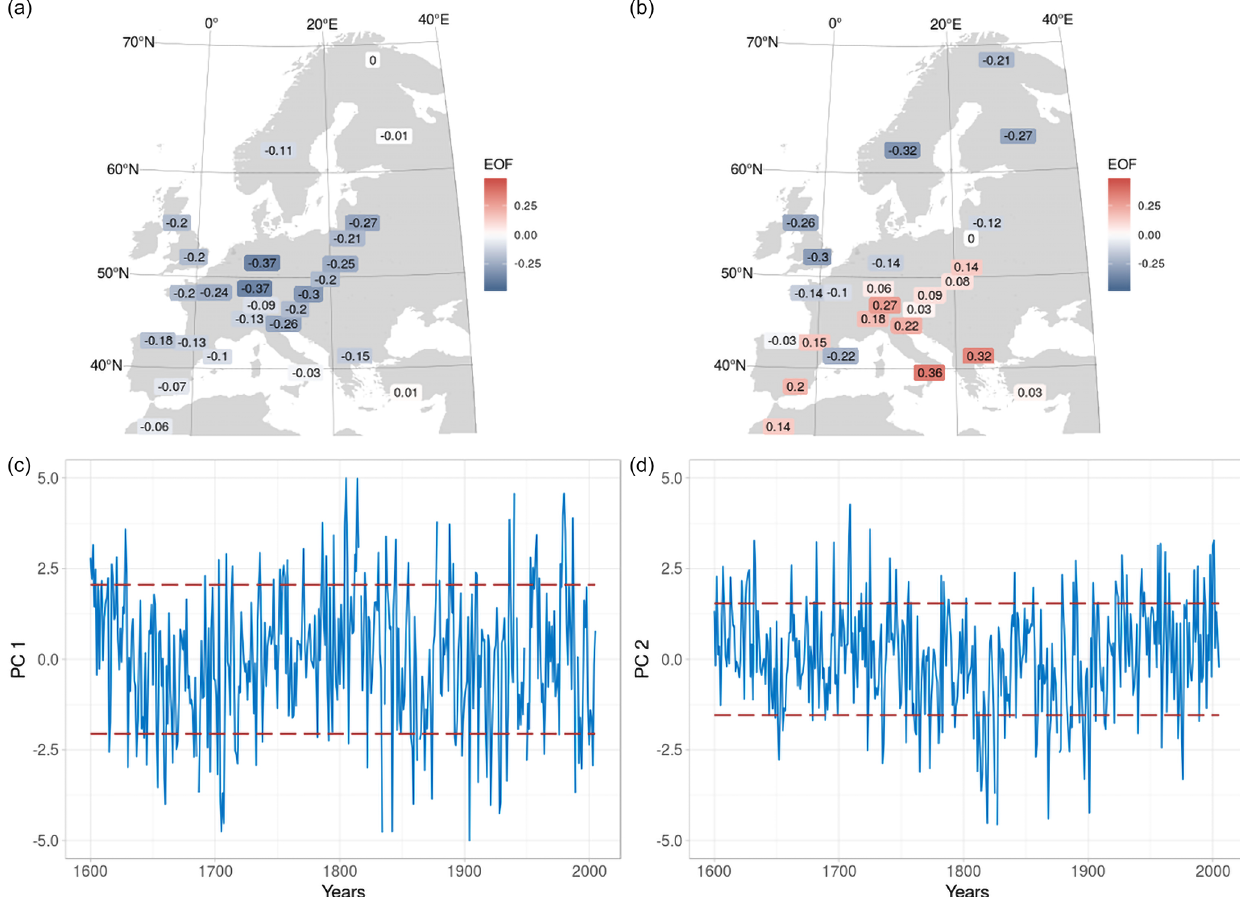
Figure 3. Spatial and temporal variability of the first two δ 18 O components and EOFs: (a) EOF for the first δ 18 O component (16.2% explained variance); (b) EOF for the second δ 18 O component (9.5% explained variance). Panels (c) and (d) show the time series for the first and second δ 18 O components. The dashed red lines indicate the standard deviation for the years 1600–2005.